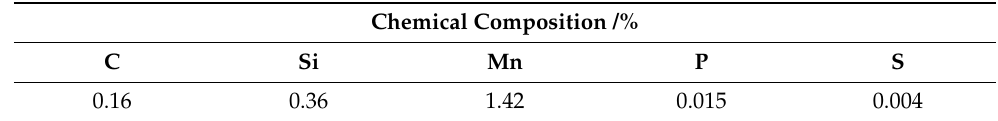
Figure 2. Specimen geometry; all measures are in mm. Table 1. Chemical composition of the mid-carbon steel.